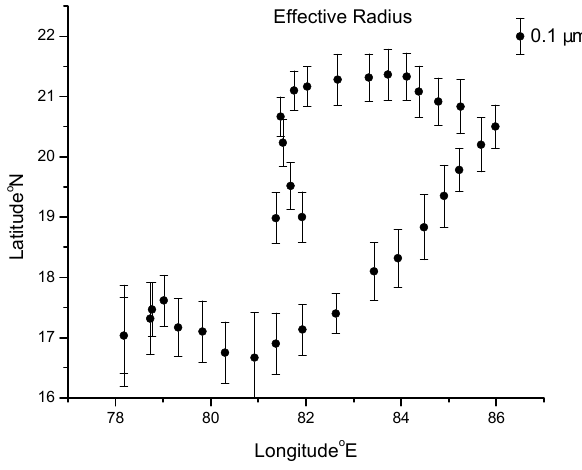
Fig. 7. Effective radii derived from QCM data for the observation sites.